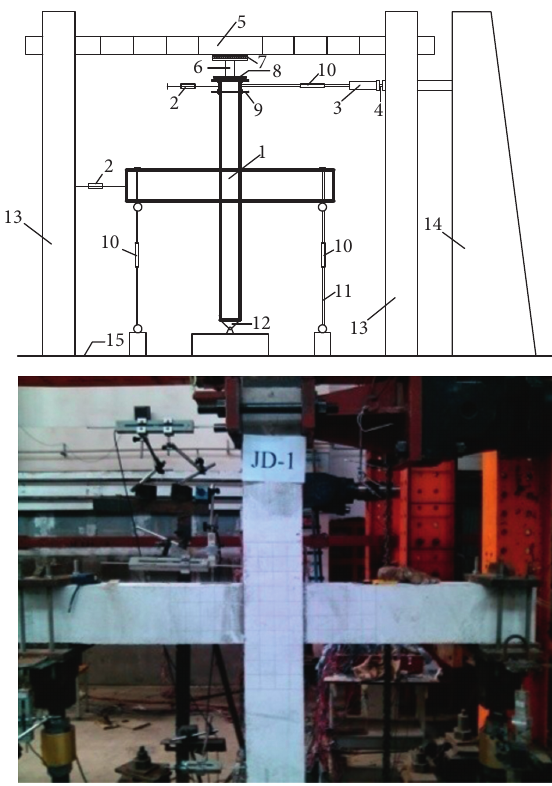
Figure 4: Test setup and arrangement of instruments. (1) Joint